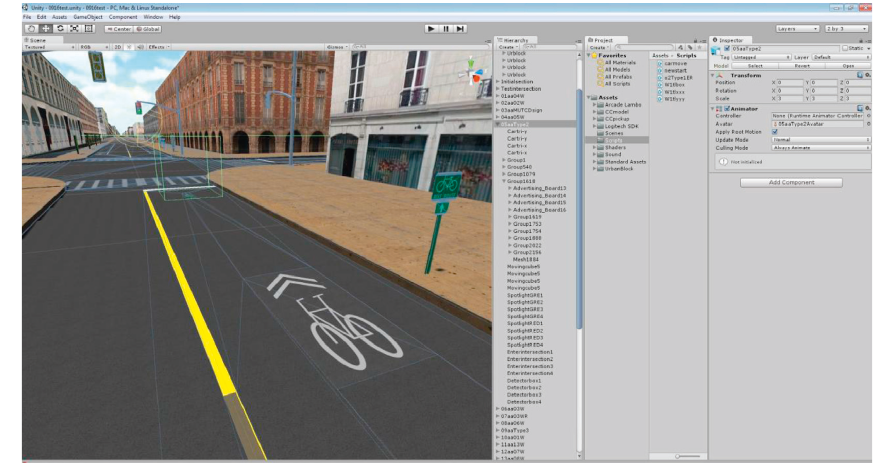
Figure 3: Example of bicycling simulator scene